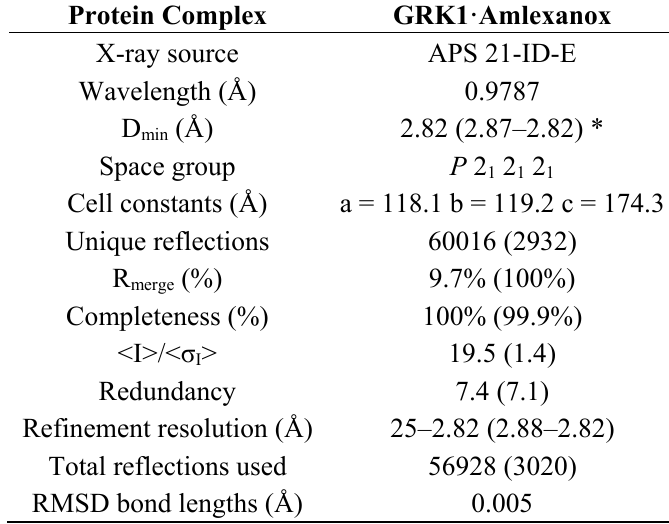
Table 1. Crystallographic collection and refinement for the GRK1·amlexanox